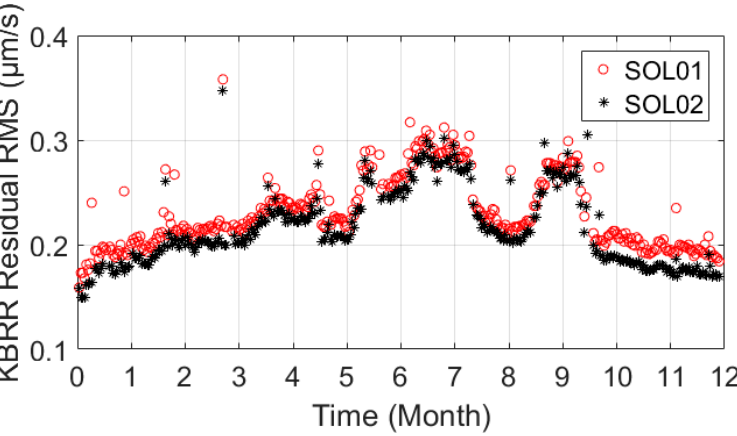
Figure 2. Daily RMS of KBRR post-fit residuals of SOL01 and SOL02 in 2006.